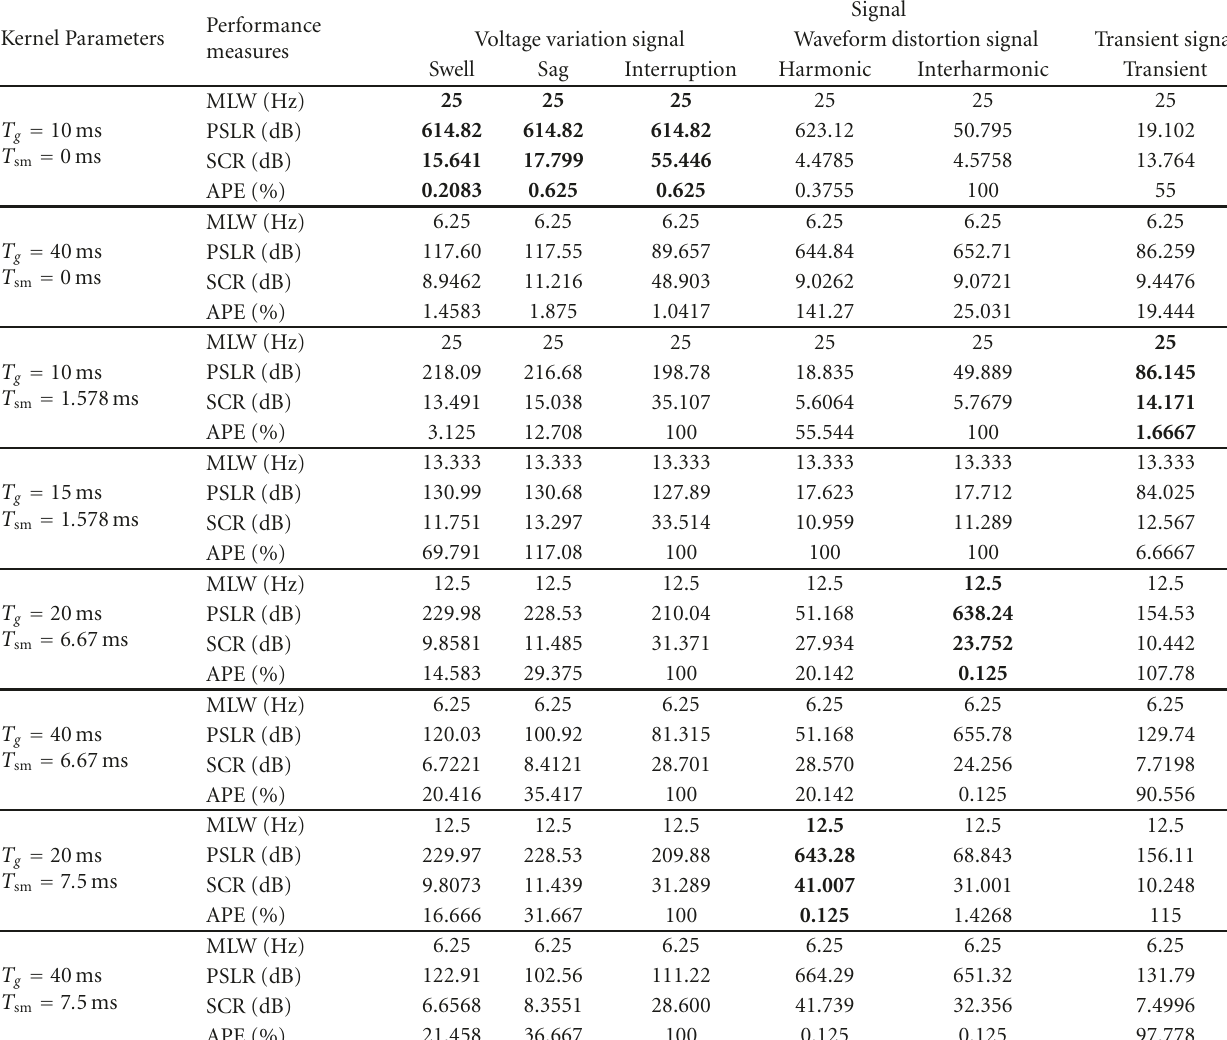
Table 3: Performance comparison of SWWVD with various kernel